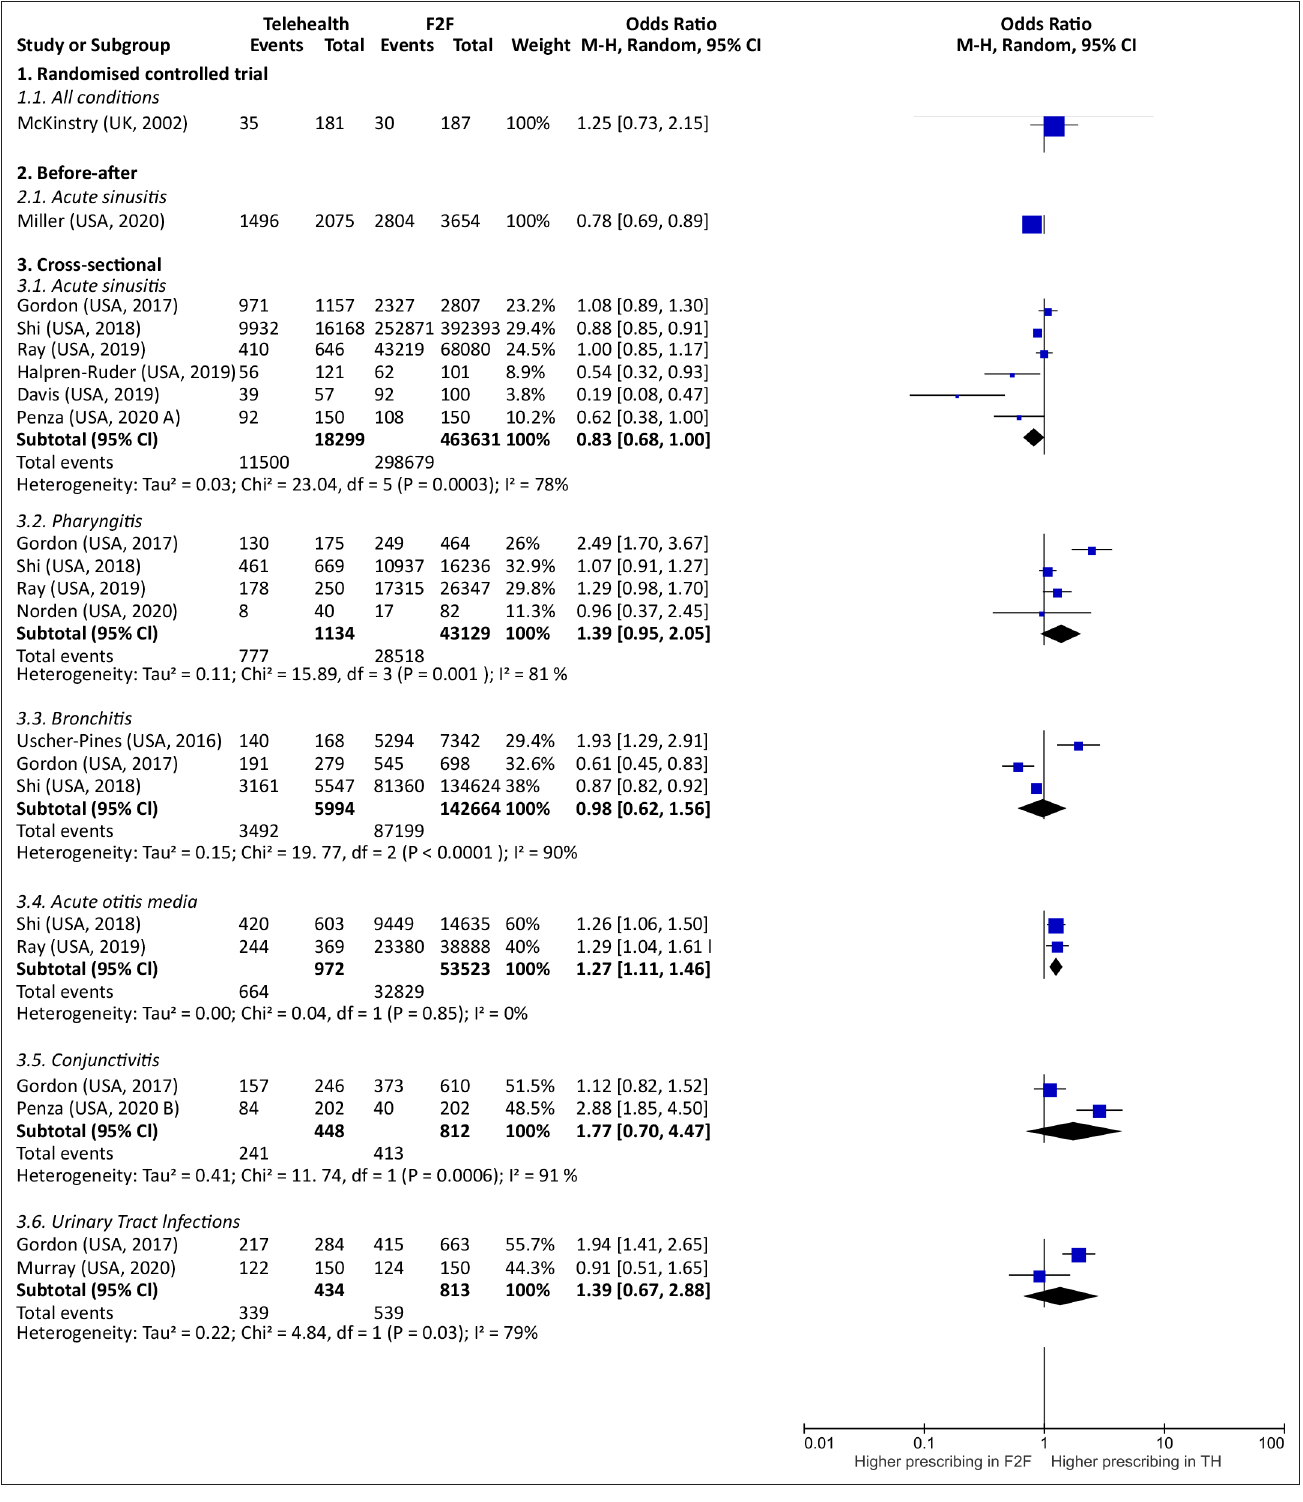
Figure 2 Antibiotic prescribing in synchronous TH compared with F2F